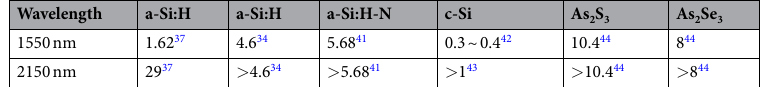
Table 1. Summary of FOMs for materials at 1550 nm and 2150 nm.